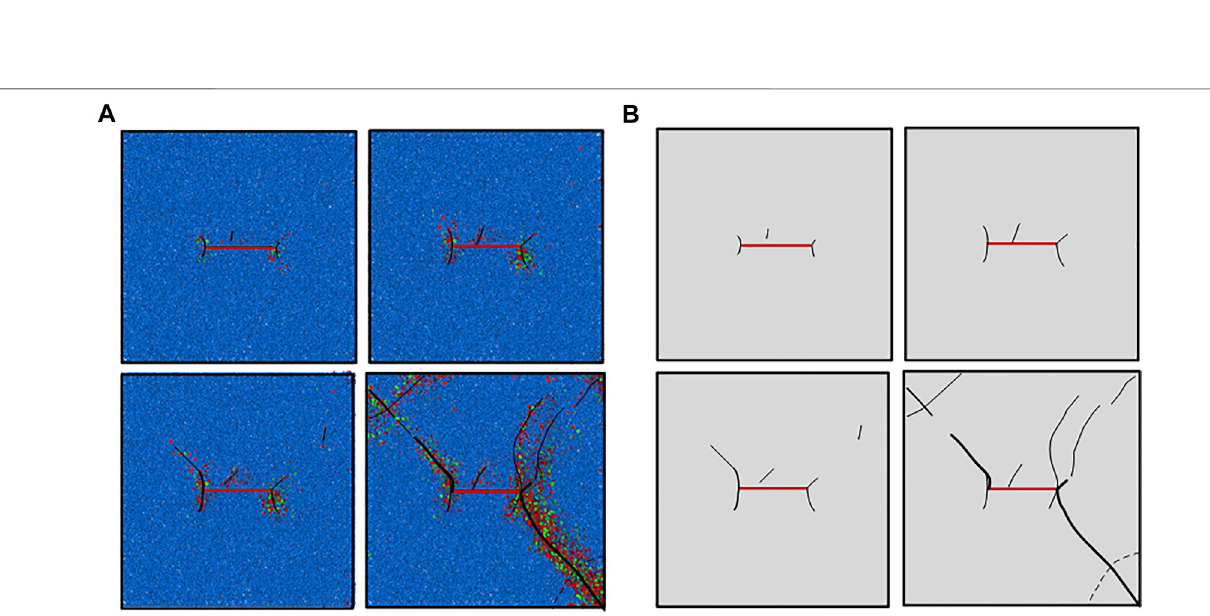
Frontiers in Earth Science |